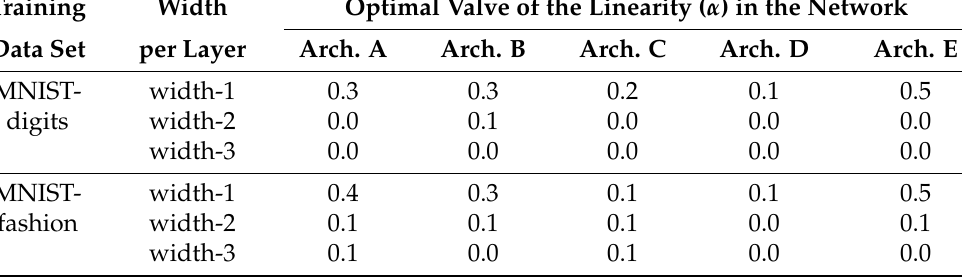
Table 2. Optimal value of the linearity factor ( α ) at which the maximum validation accuracy was achieved for neural network models tested using MNIST-digits and MNIST-fashion images. Width of each model architecture shape was varied by changing the number of nodes per layer. See Table 1 for the number of nodes per layer corresponding to the network widths used in each